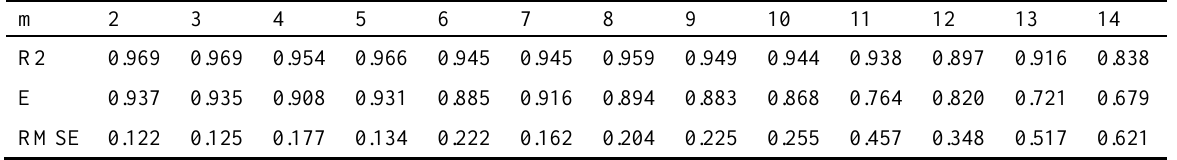
Table 2 Local Prediction Using Different Embedding Dimension for River